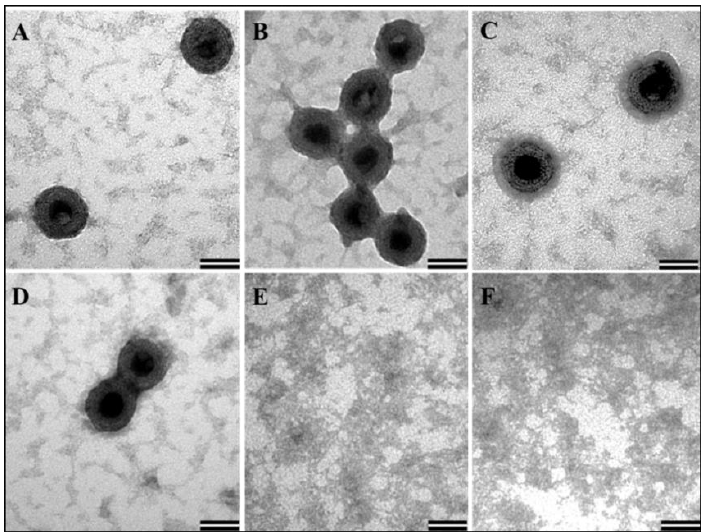
Figure 7. Transmission electron micrographs showing virus-like particles (VLPs) following in vitro